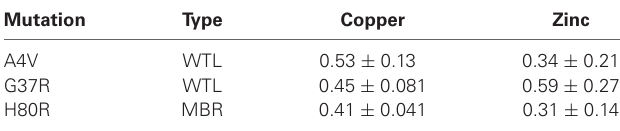
Table 1 | The ratio of aggregate/cytoplasm concentration for copper and zinc in the SOD1 mutant cells